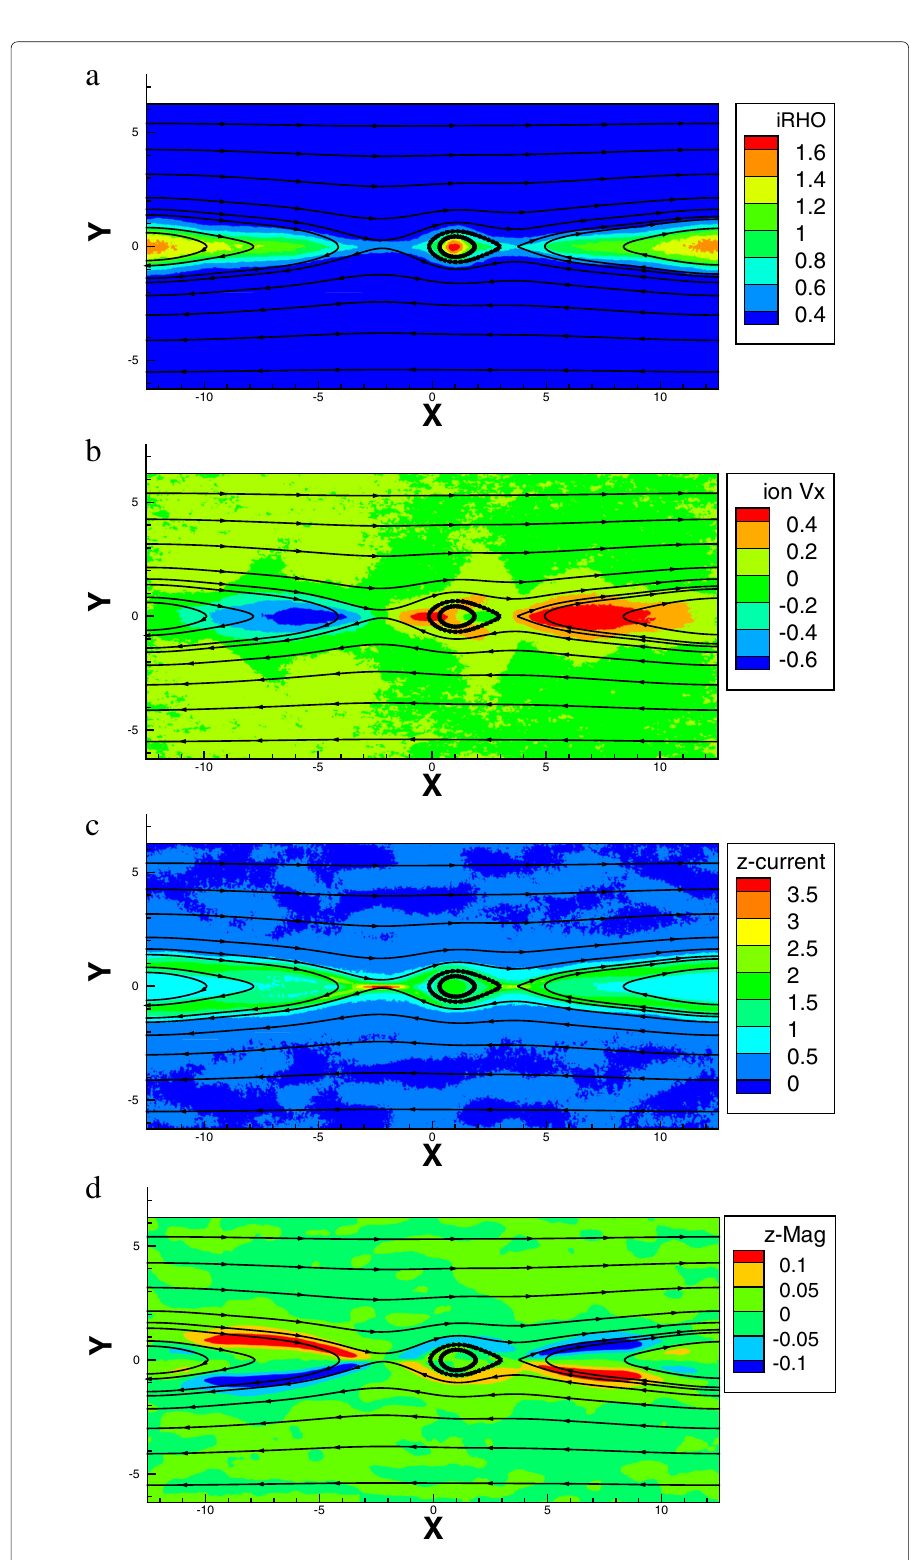
Fig. 17 The UGKWP results of magnetic reconnection with Kn=10 3 at pi